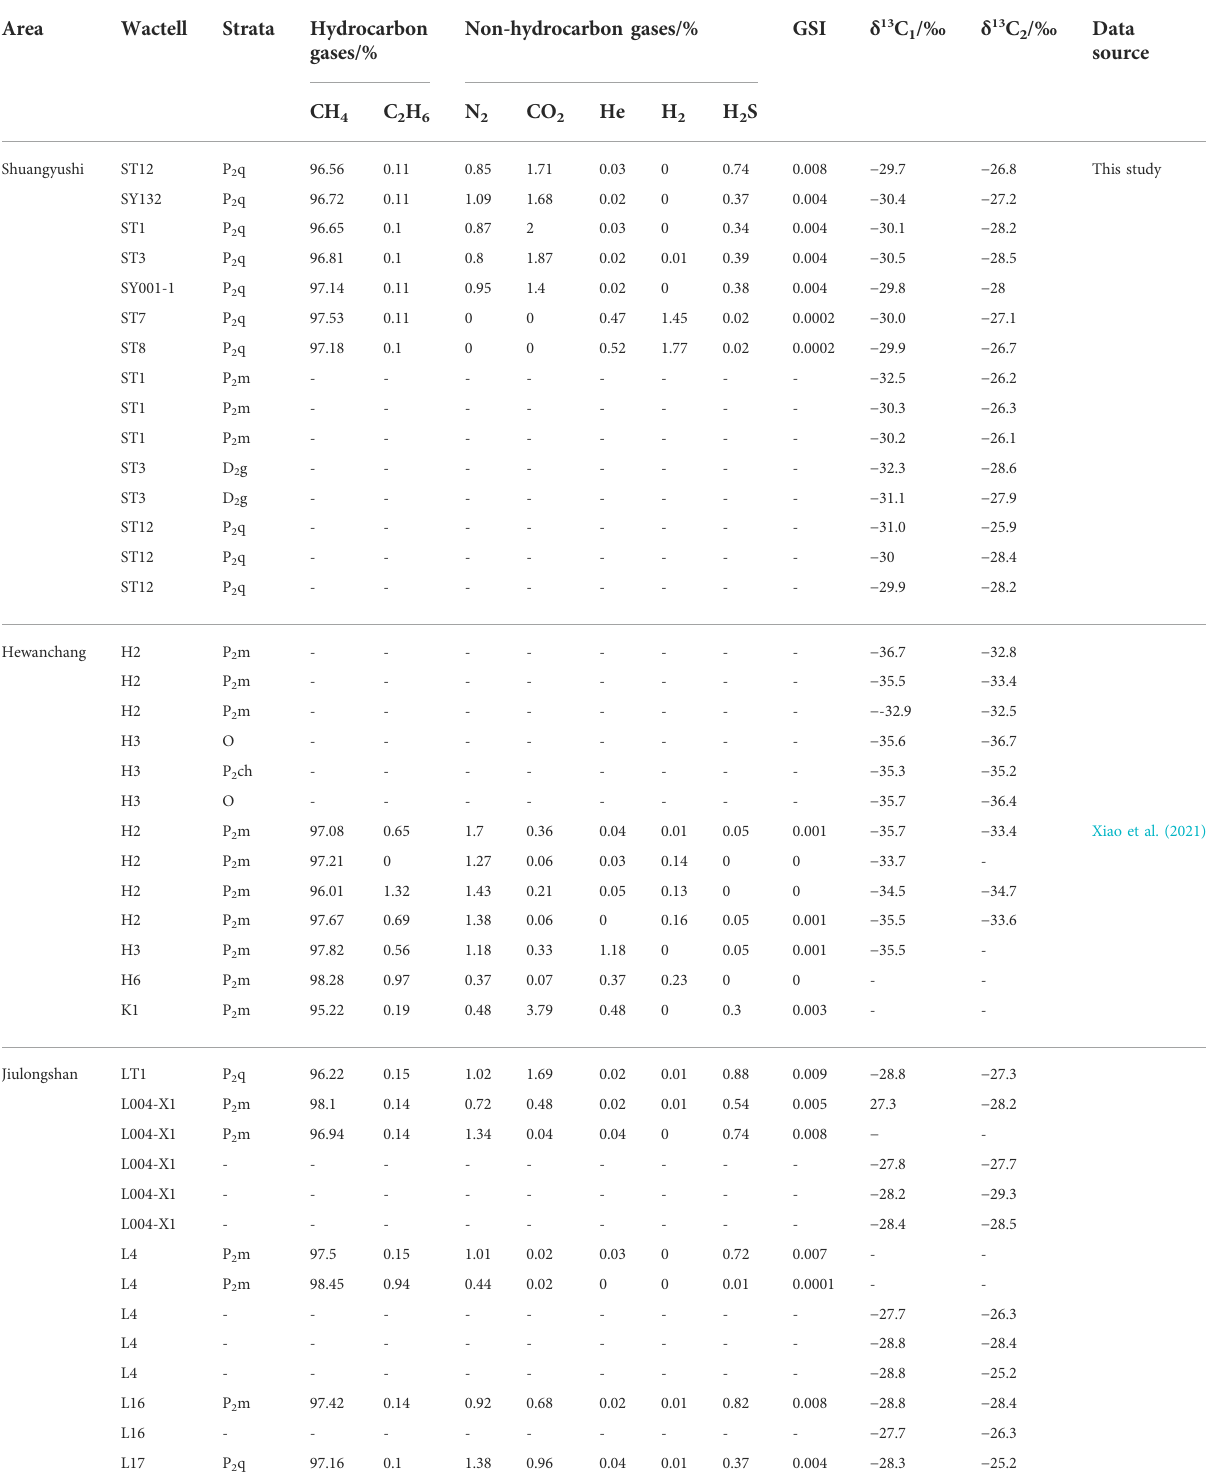
TABLE 1 Compositions and carbon isotopes of natural gas samples from different areas. Area